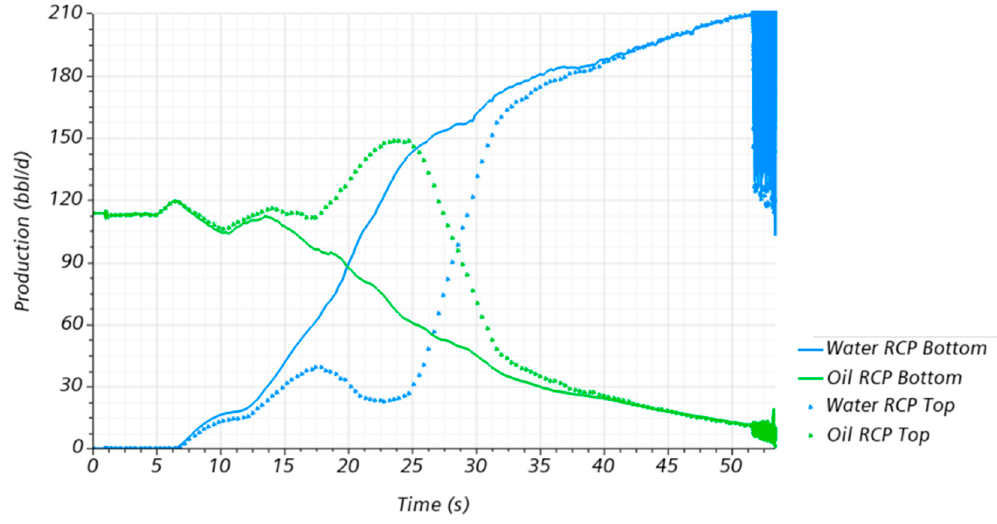
Figure 9. Production profiles obtained for the two RCP valves implemented in the AICD assembly. On the contrary, the RCP at the top had a higher oil production for a longer time span. However, after a while (approx. 40 s), oil and water flow rates per RCP converged to the same rate. When the water reached 210 bbl/d per valve (and oil decreased to 20 bbl/d, at an approximate water cut of 90%), the disks started